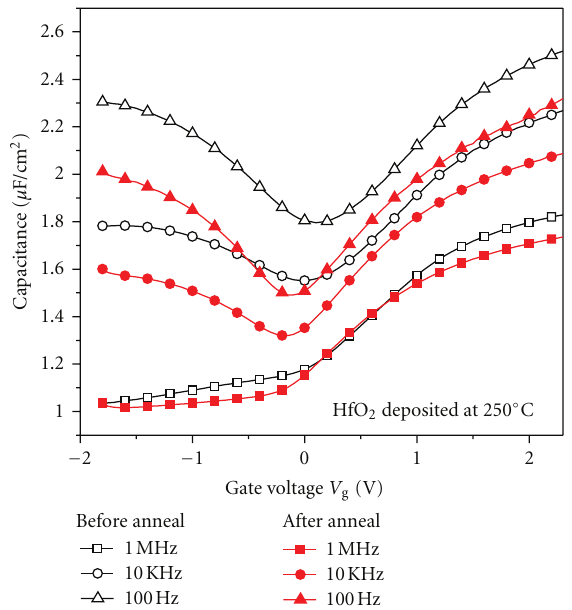
Figure 5: Frequency-dependent C - V characteristics of Pt/HfO 2 / InP/InAs MOS capacitors in which HfO 2 was deposited at 250 ◦ C before and after a subsequent 300 ◦ C forming gas